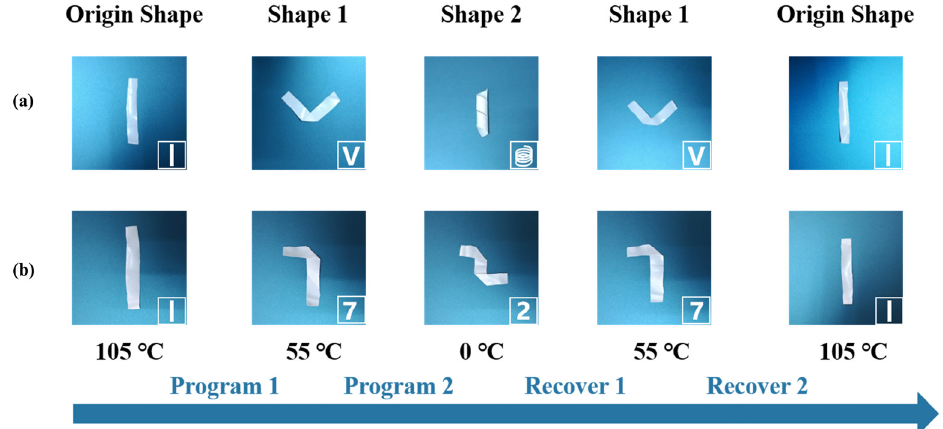
Figure 5. Photographs of the triple shape memory effect of the T/E-D0.4 composite: ( a ) first shape memory cycle; ( b ) second shape memory